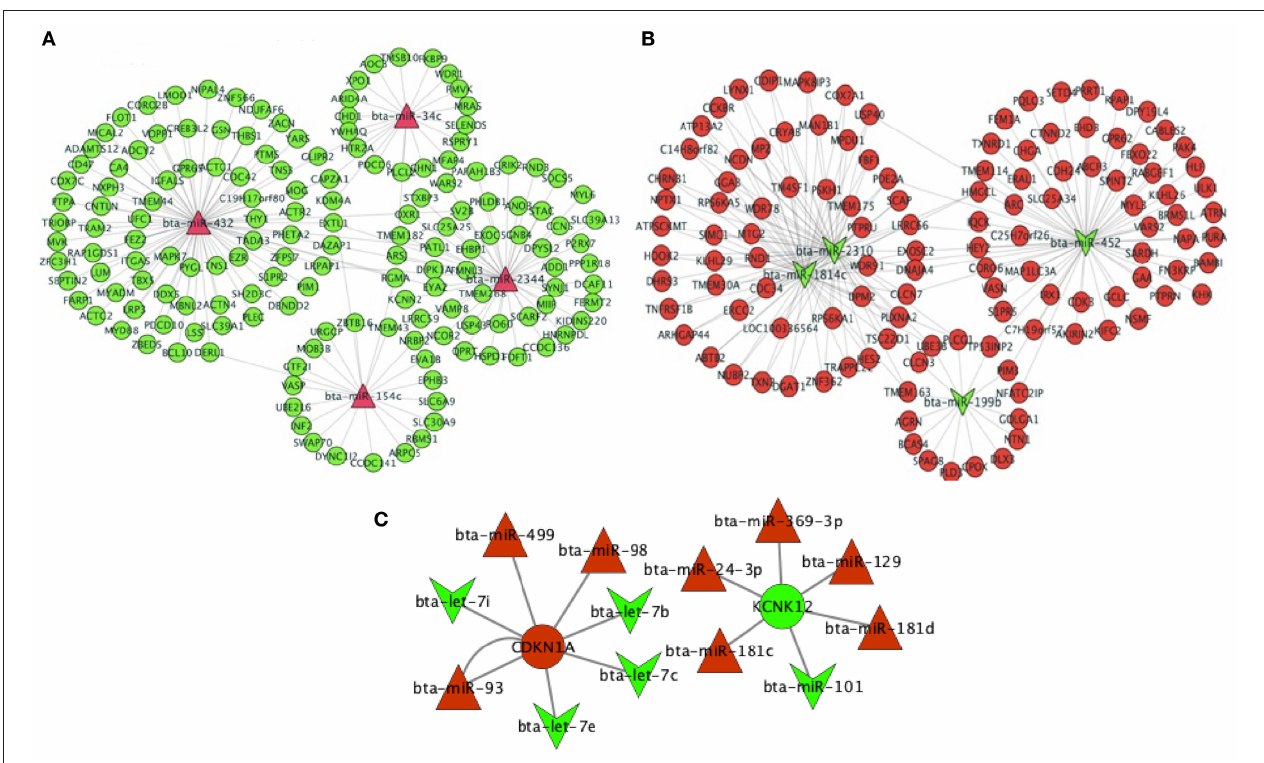
FIGURE 9 | mRNA–miRNA network of the top four differentially expressed (DE) miRNAs in the (A) up-regulated status (bta-miR-34c, bta-miR-432, bta-miR-2344, and bta-miR-154c) and the (B) down-regulated status (bta-miR-199b, bta-miR-2310, bta-miR-1814c, and bta-miR-452) in the key turquoise module and their targeted DE genes. (C) mRNA–miRNA network of the top two DE genes and the targeting DE miRNAs. DE mRNA and miRNA results were achieved from our previous study (31, 32). The green color indicates the down-regulated miRNAs and genes, while the red color indicates the up-regulated miRNAs and genes.